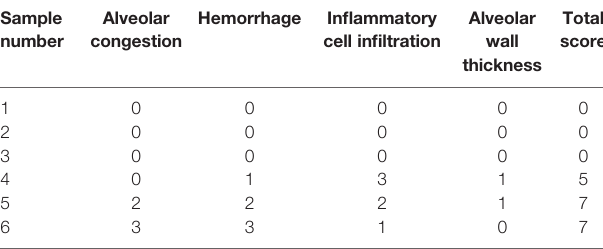
TABLE 1 | Pathological score in the